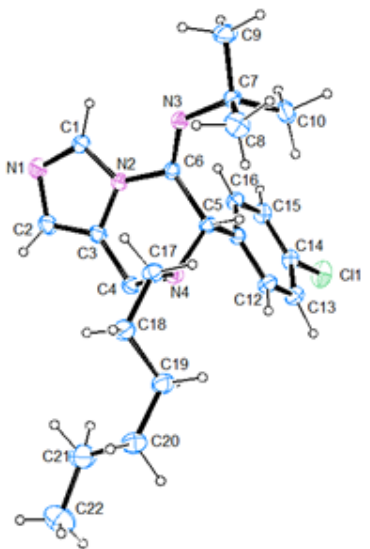
Figure 5. ORTEP [33] view of 79 and the relative arbitrary atom-numbering scheme (thermal ellipsoids at 40% probability).